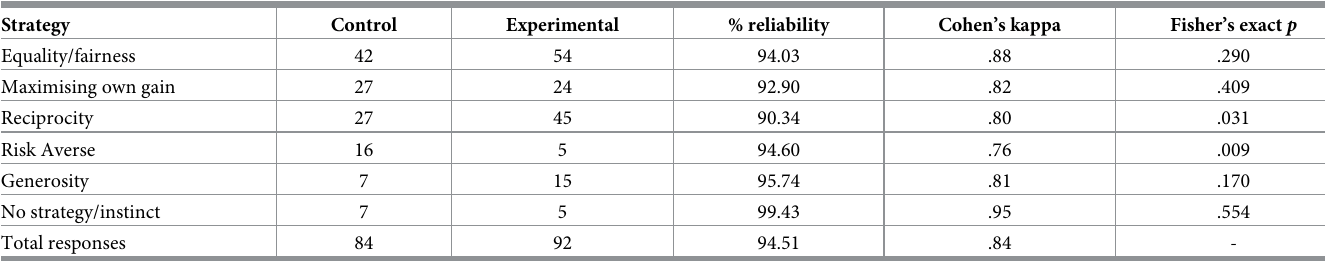
Table 4. Themes derived from the qualitative data (Experiment 2).